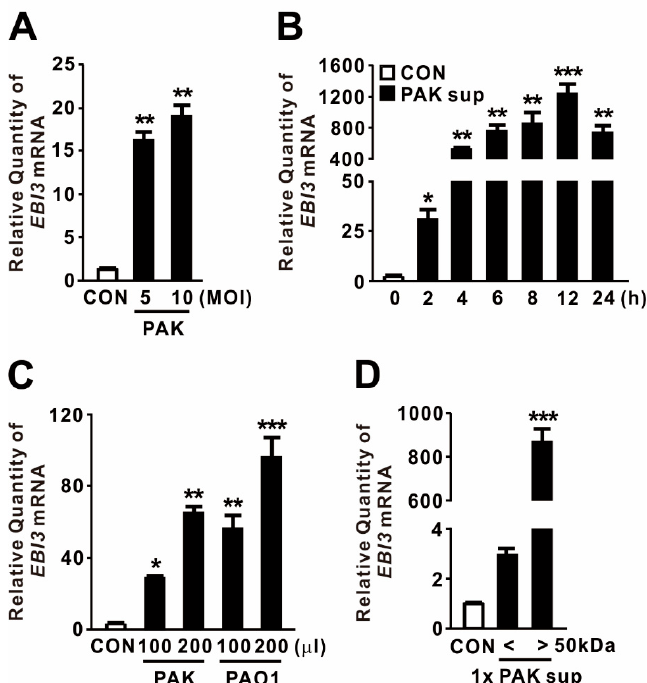
Figure 1. P. aeruginosa -mediated induction of Epstein–Barr virus-induced gene 3 ( EBI3) expression. ( A ) dTHP-1 cells were treated with P. aeruginosa strain PAK at a multiplicity of infection (MOI) of 5 or 10 for 4 h. ( B ) dTHP-1 cells were treated for the indicated times with 100 μ L culture supernatant (Sup) obtained from PAK. ( C ) dTHP-1 cells were treated for 4 h with 100 or 200 μ L Sup obtained from P. aeruginosa strains PAK and PAO1. ( D ) dTHP-1 cells were treated for 4 h with 100 μ L Sup, size-fractionated using a 50 kDa pore size membrane filter. After treatment, EBI3 mRNA levels were quantified by qRT-PCR. Data are expressed as means ±SD ( n = 3). *, p < 0.05; **, p < 0.01; ***, p < 0.001 vs. CON. MOI, multiplicity of